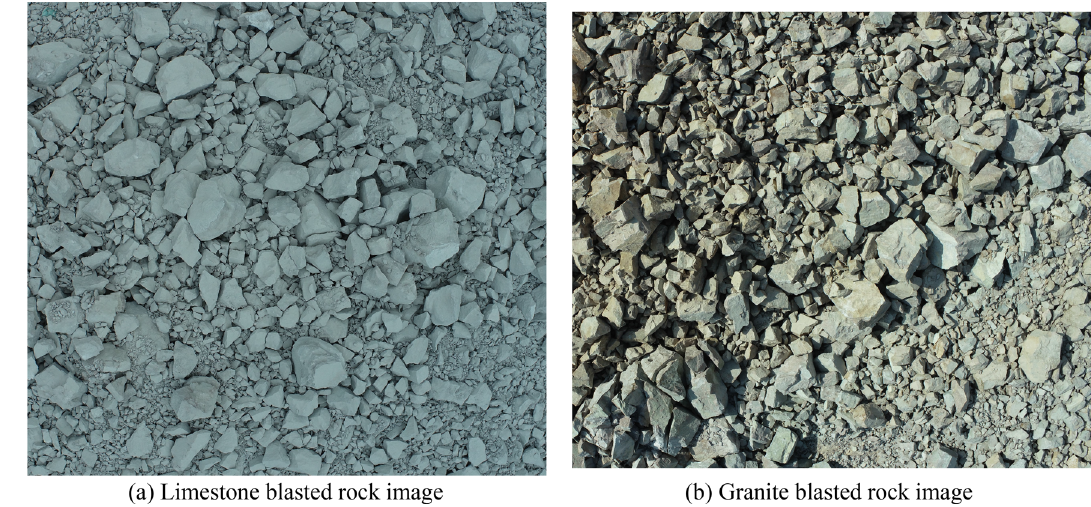
Figure 4. Blasted rock images acquired by